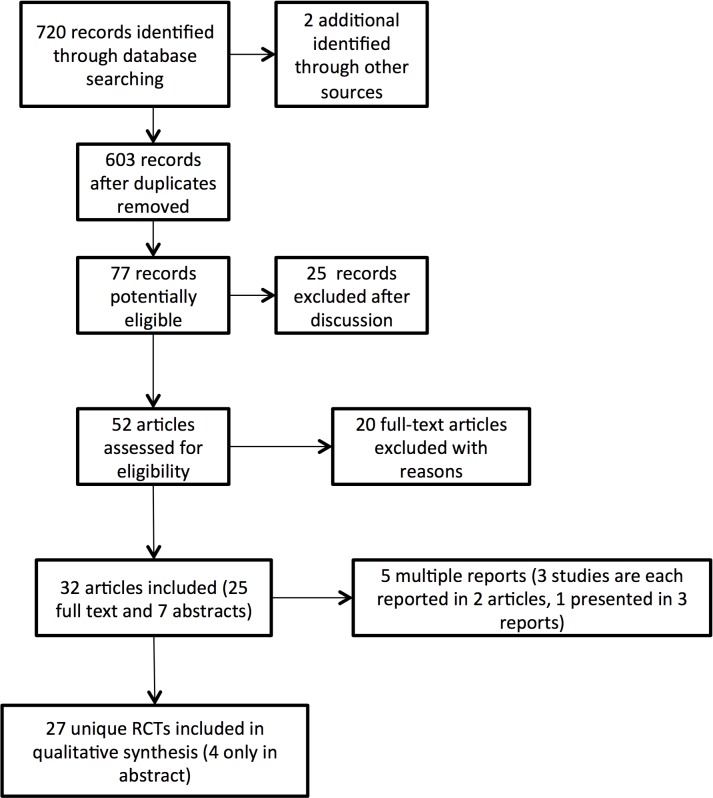
Study flow diagram.